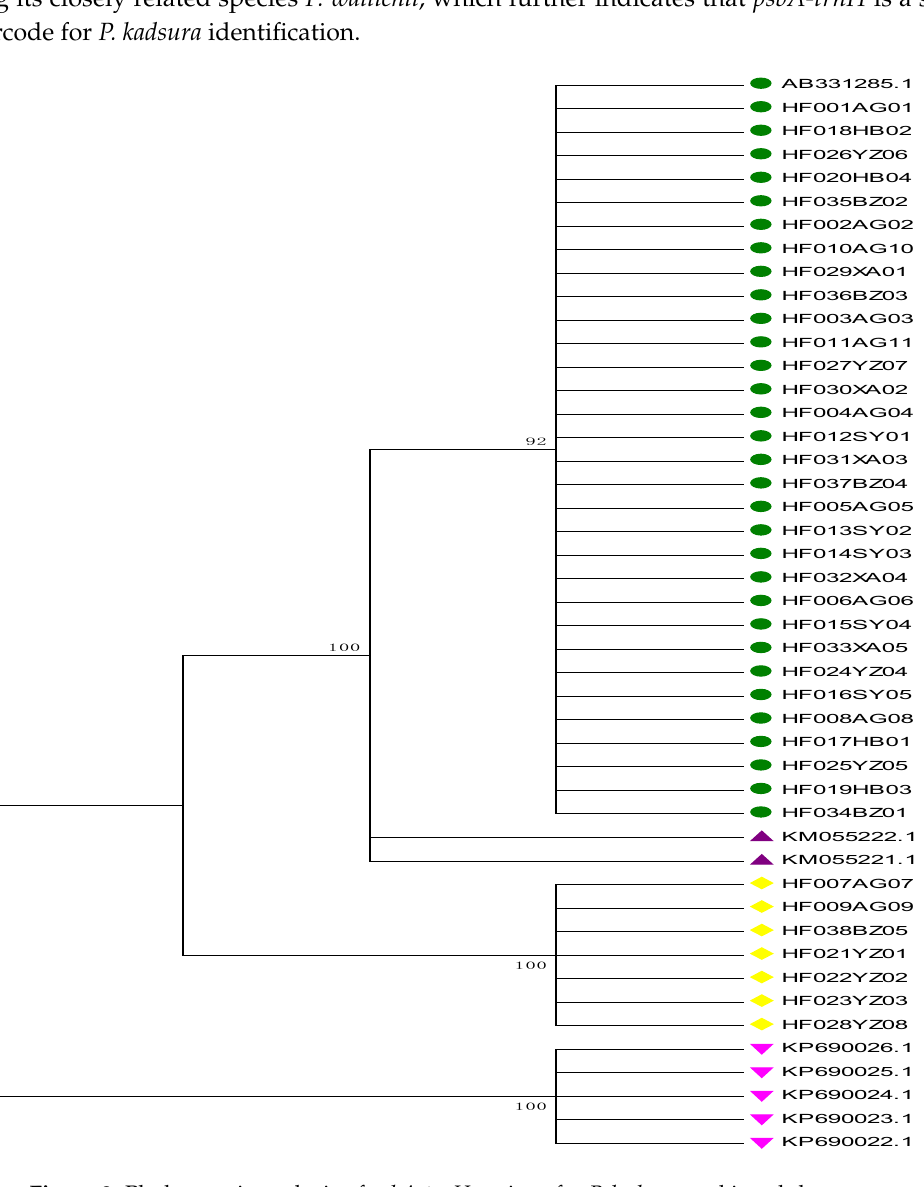
Figure 3. Phylogenetic analysis of psbA-trnH regions for P. kadsura and its adulterants.